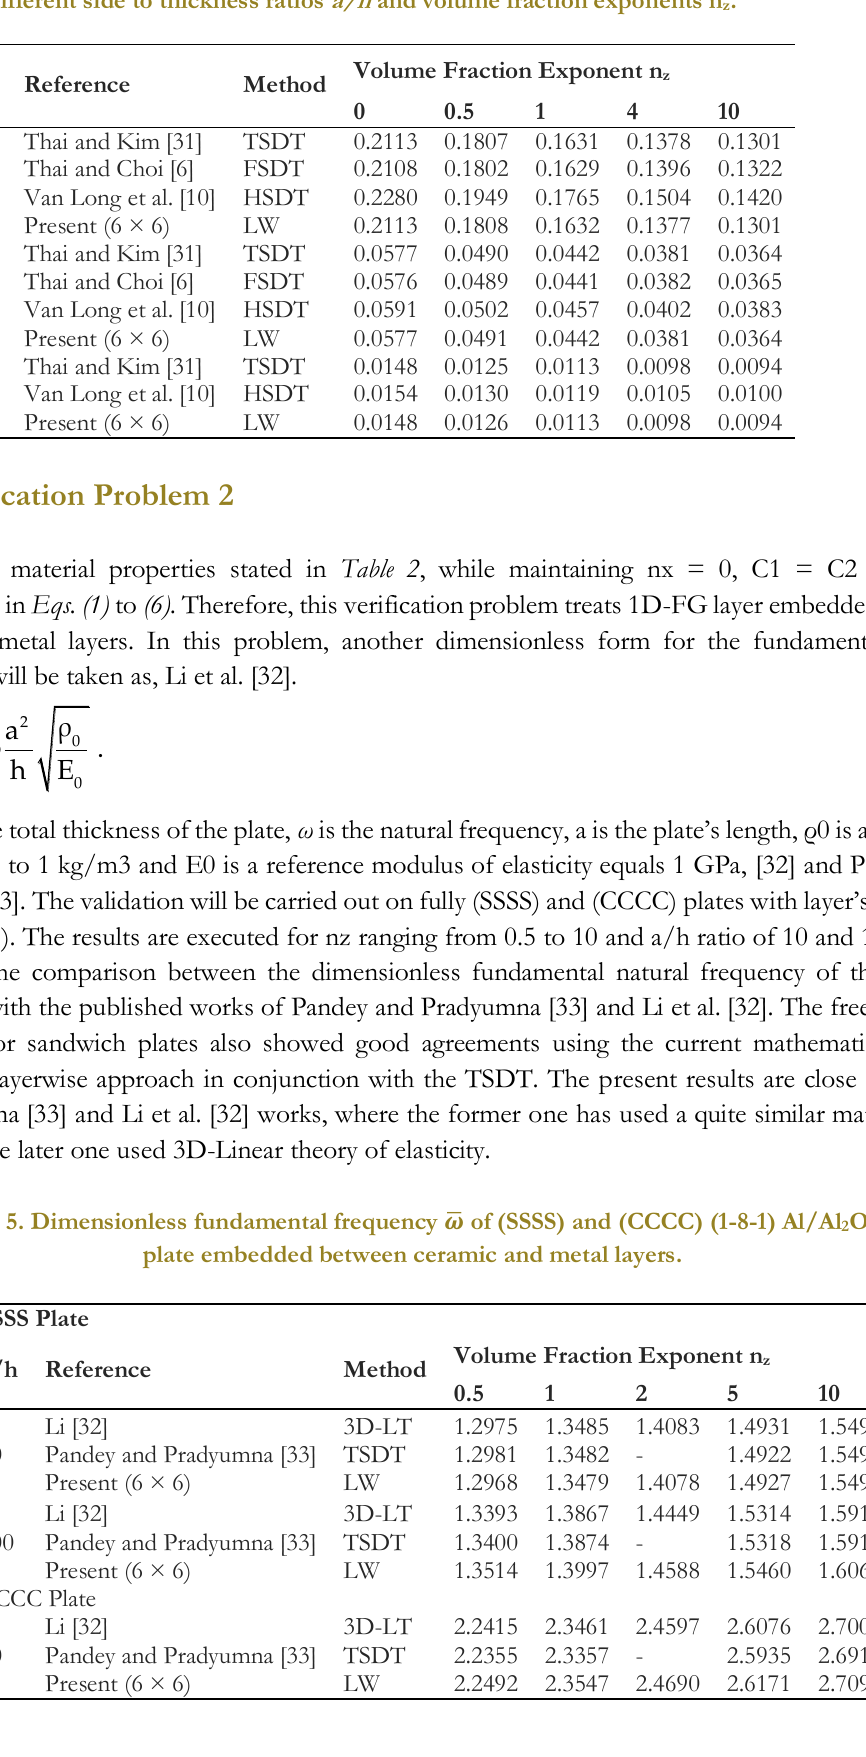
Table 4. Dimensionless fundamental frequency 𝝎̅ for (SSSS) Al/ Al 2 O 3 Square plate with different side to thickness ratios a/h and volume fraction exponents n z .